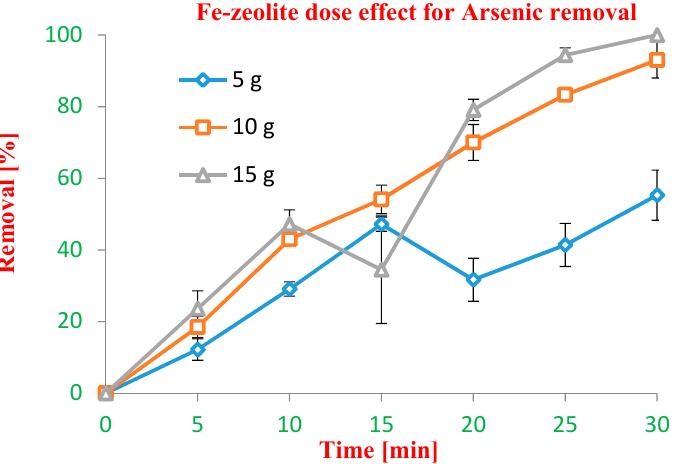
Figure 12. Catalyst dose effect in arsenic removal studies during catalytic ozonation process (ozone dose = 0.2 mg/min, As = 68 ± 8 ppb, Fe-ZA dose = 5 g/L, 10 g/L and 15 g/L, pH = 7.8 ± 0.3, volume = 1 L, time = 30 min, T = 33 ± 2 °C).